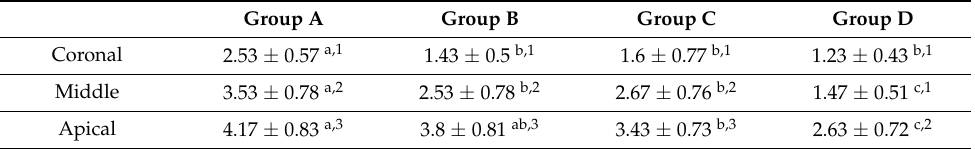
Table 2. Mean values of smear layer scores (mean ± standard deviation) in different groups (A, B, C and D) divided by the three regions of root canal (Coronal, Middle and